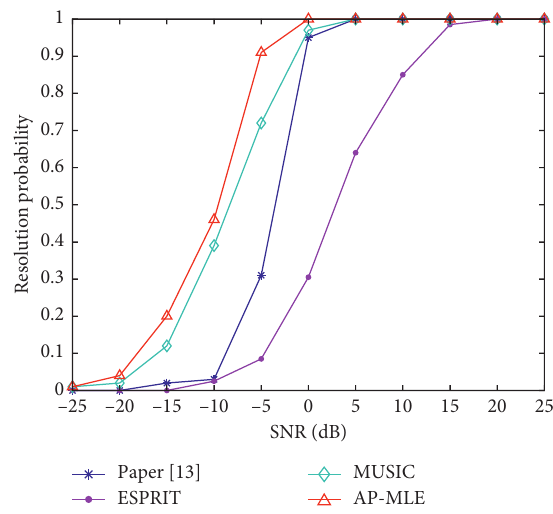
Figure 9: Resolution probability curves versus